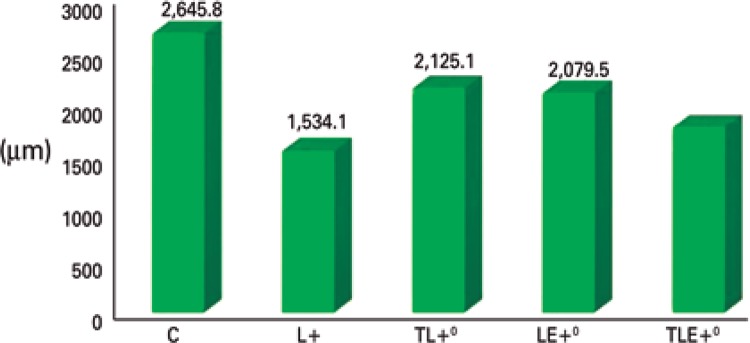
Muscle fiber area